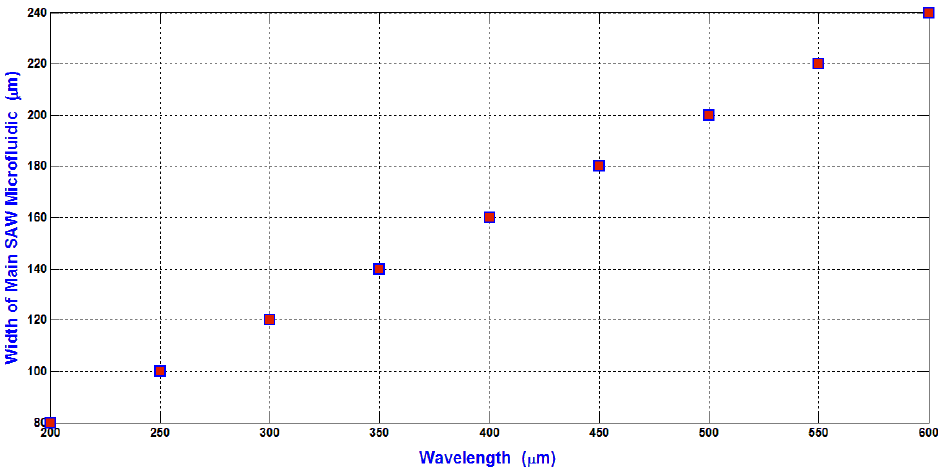
Figure 6. The relation between the width of the main SSAW microchannel and the wavelength.